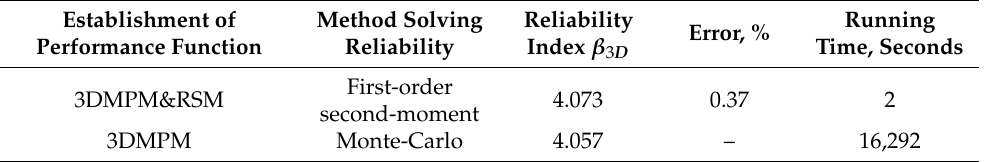
Table 3. Comparison with the Monte-Carlo technique.